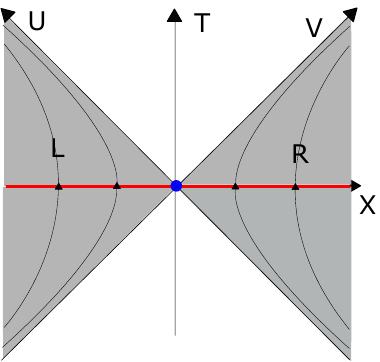
Figure 1 . Rindler wedges and coordinate systems. At T = 0, the Minkowski Hilbert space splits into the left and right Hilbert space. The Rindler observer then evolves these states using H R along the hyperbolic trajectories. This is one way of making sure the right observer does not see anything originating from the left wedge. Likewise, the left Hilbert space evolves upwards with H L